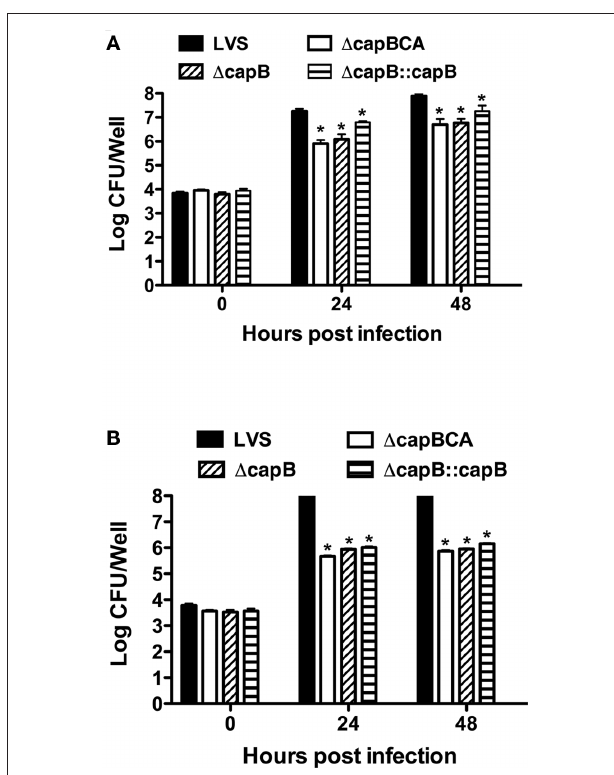
Figure 4 | intracellular growth of F. tularensis capBCA mutants . (A) Intracellular growth of LVS derivatives in MH-S macrophages. Macrophages were infected at a multiplicity of infection of ∼ 100:1 (bacterium vs. macrophage) with LVS, isogenic ∆ capBCA (strain ST938), ∆ capB (strain ST1092), or complemented ∆ capB ( ∆ capB:: capB, strain ST1104). Total bacteria per well were enumerated at the indicated time points. Statistic significance between LVS and its isogenic capBCA mutants ( p > 0.05) was determined using Student’s t test. (B) Intracellular growth of LVS derivatives in U937 macrophages. The infection experiments were carried out and analyzed as in